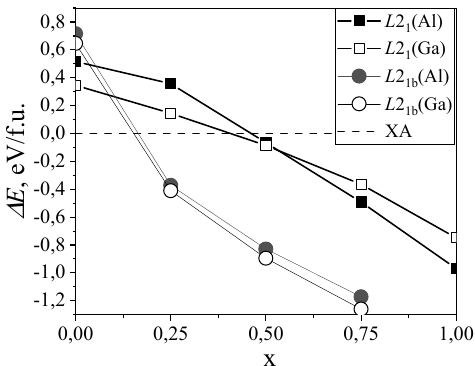
Figure 2. The ground state energies for the XA, L 2 1 and L2 1b structures in the Mn 2 Co 1-x V x Z compo- sitions as a function of V concentration